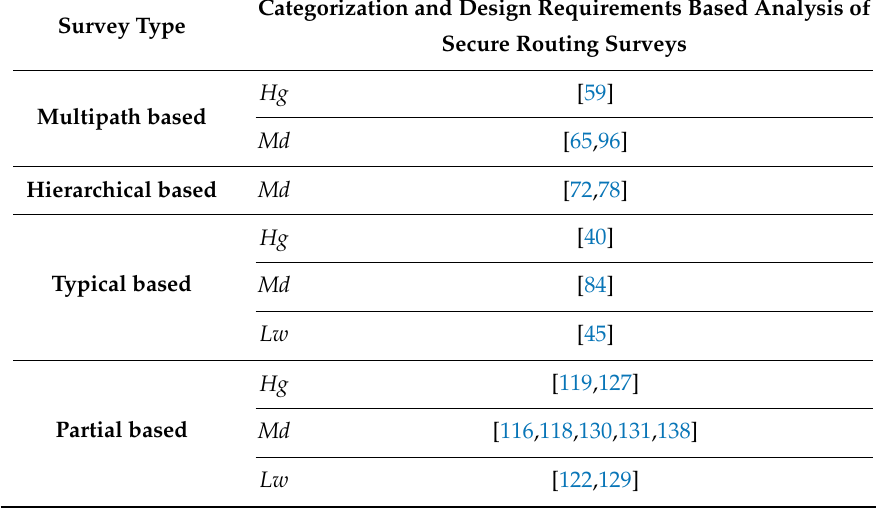
Table 7. Design analysis of secure routing surveys in